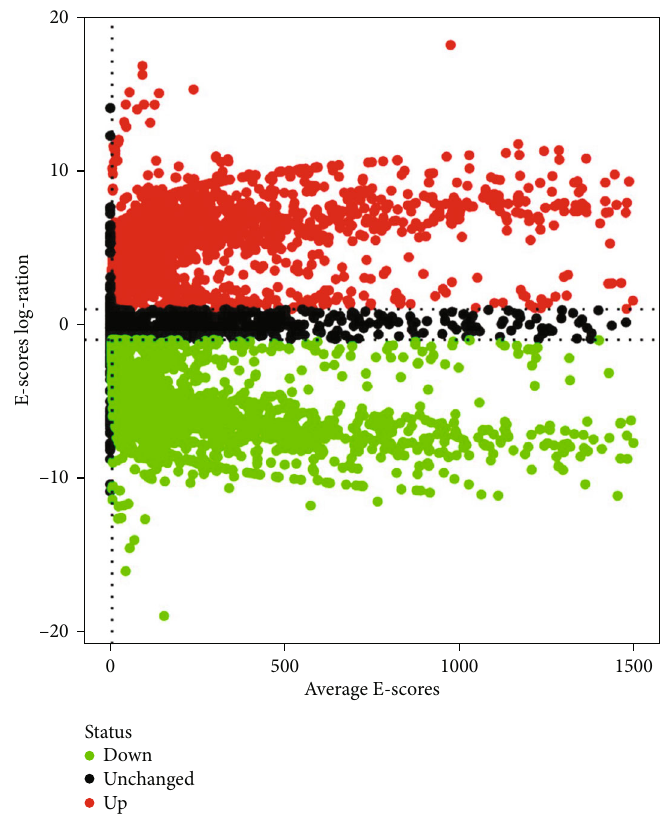
Figure 3: Functional area peak distribution. By exhibiting the involved upregulated and downregulated transcripts, the volcano plot demonstrated the distinct expression of transcripts in the MeRIP-Seq analysis. The abscissa represented the mean E -scores of the two groups, and the ordinate marked the multiple log values of E -scores in the two 2